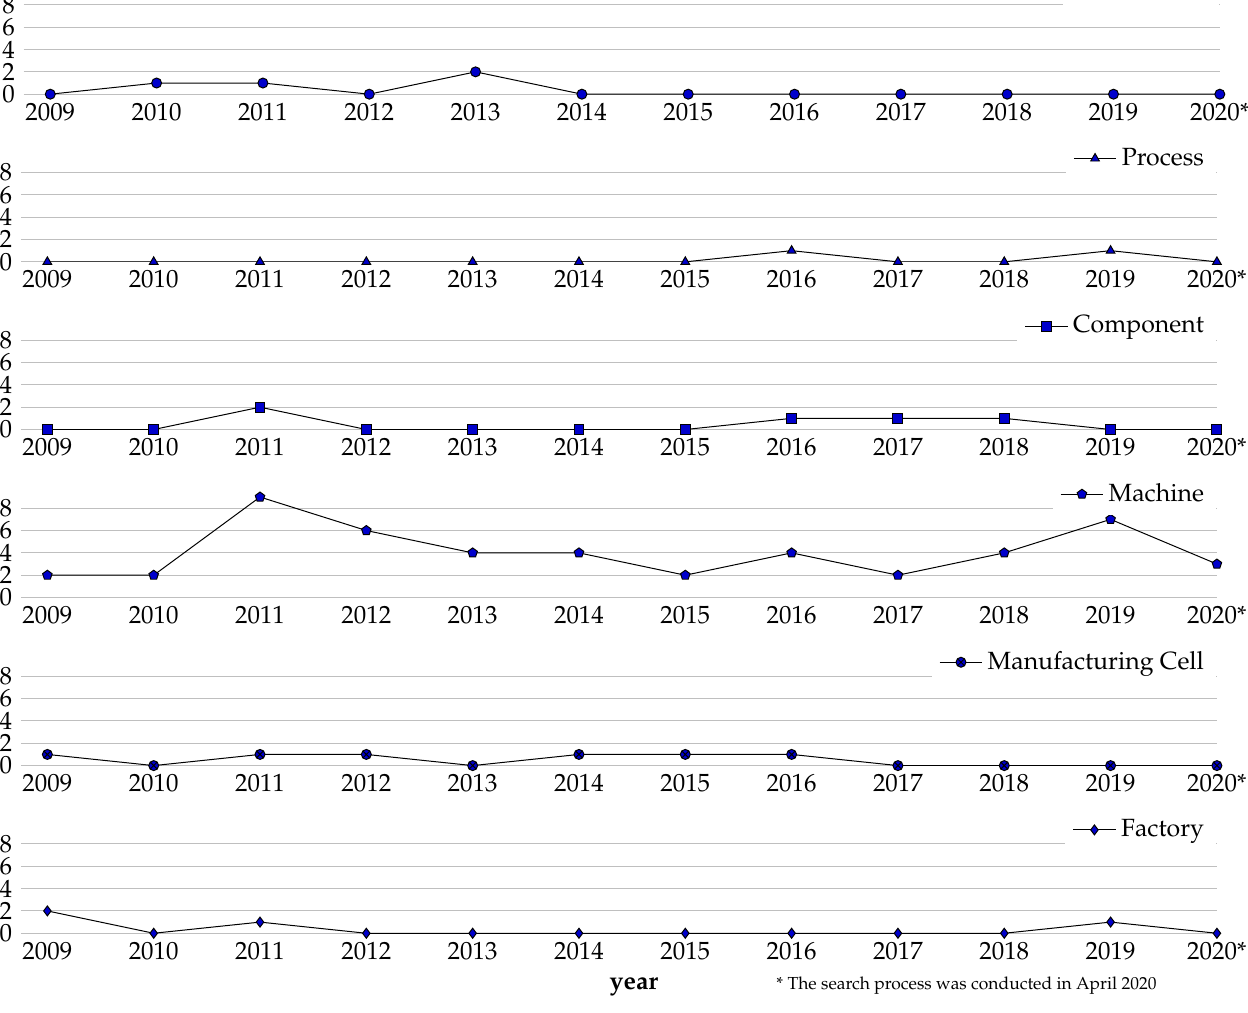
Figure 5. Number of articles over time for the category System